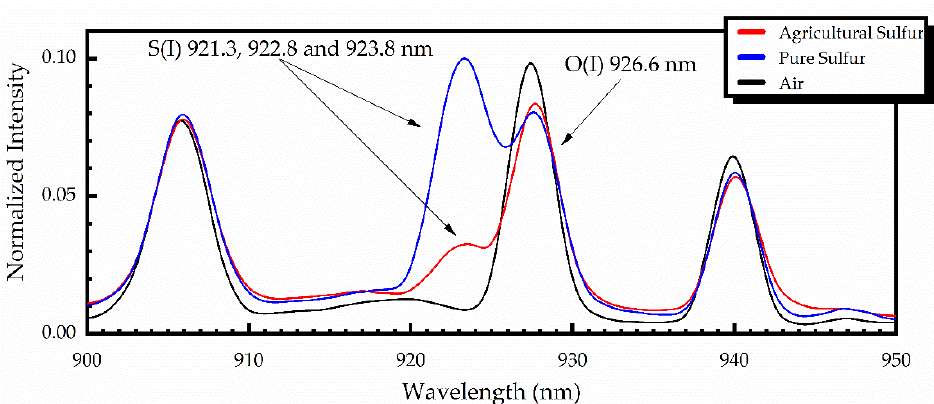
Figure 5. Unresolved emission lines of sulfur at 921.3, 922.8, and 923.8 nm, appearing as one line at about 923 nm, obtained from pure (blue) and agricultural (red) sulfur samples. The black line corresponds to the LIBS spectrum of air.